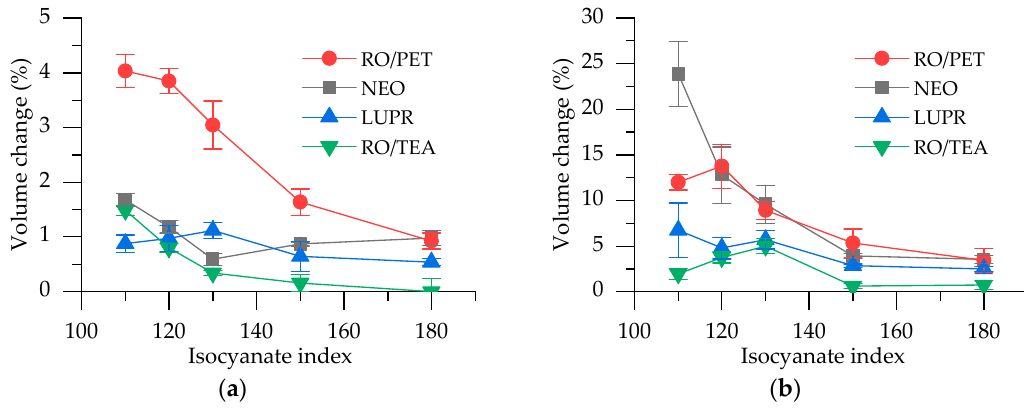
Figure 6. Dimensional stability – volume relative change at two modes: ( a ) 28 days at 70°C, ambient relative humidity (R.H.); ( b ) 28 days at 70°C, R.H. = 97%